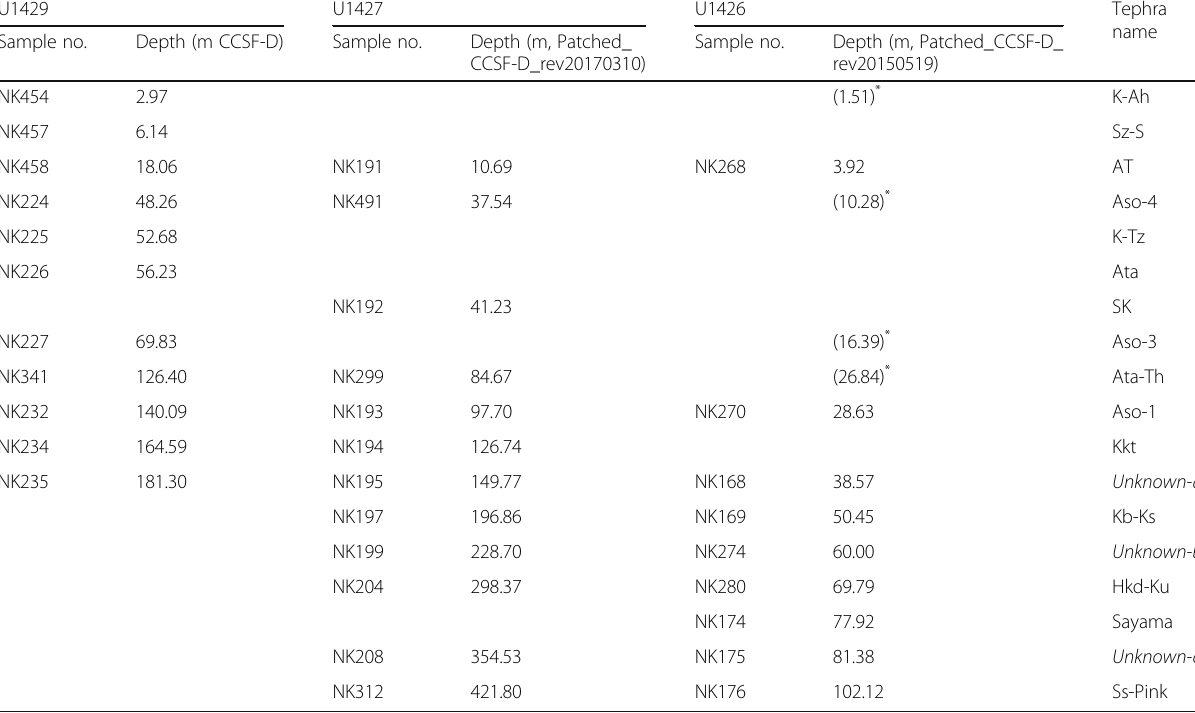
Table 1 Tephra layers identified at Sites U1426, U1427, and